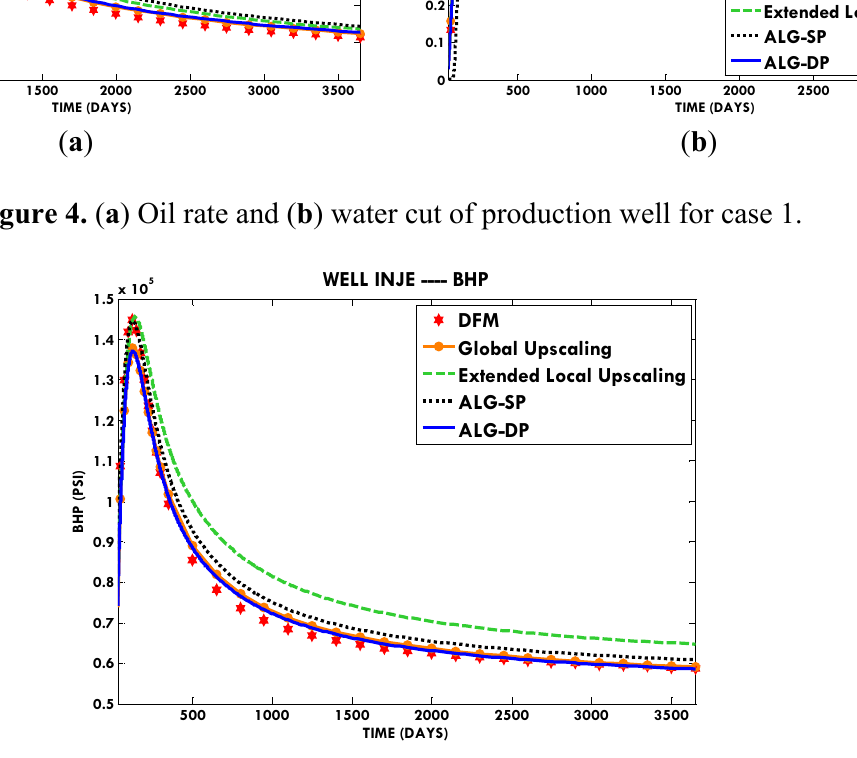
Figure 5. Bottom hole pressure (BHP) of injection well for case